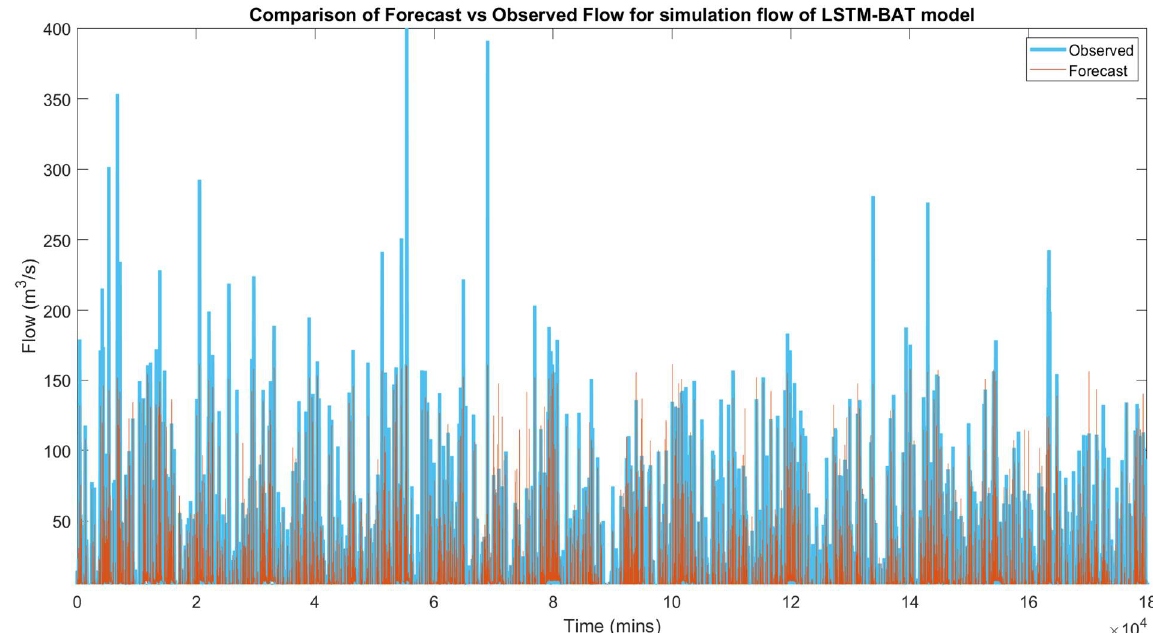
Bat algorithm: observed vs. forecast—flow simulation Figure 9.